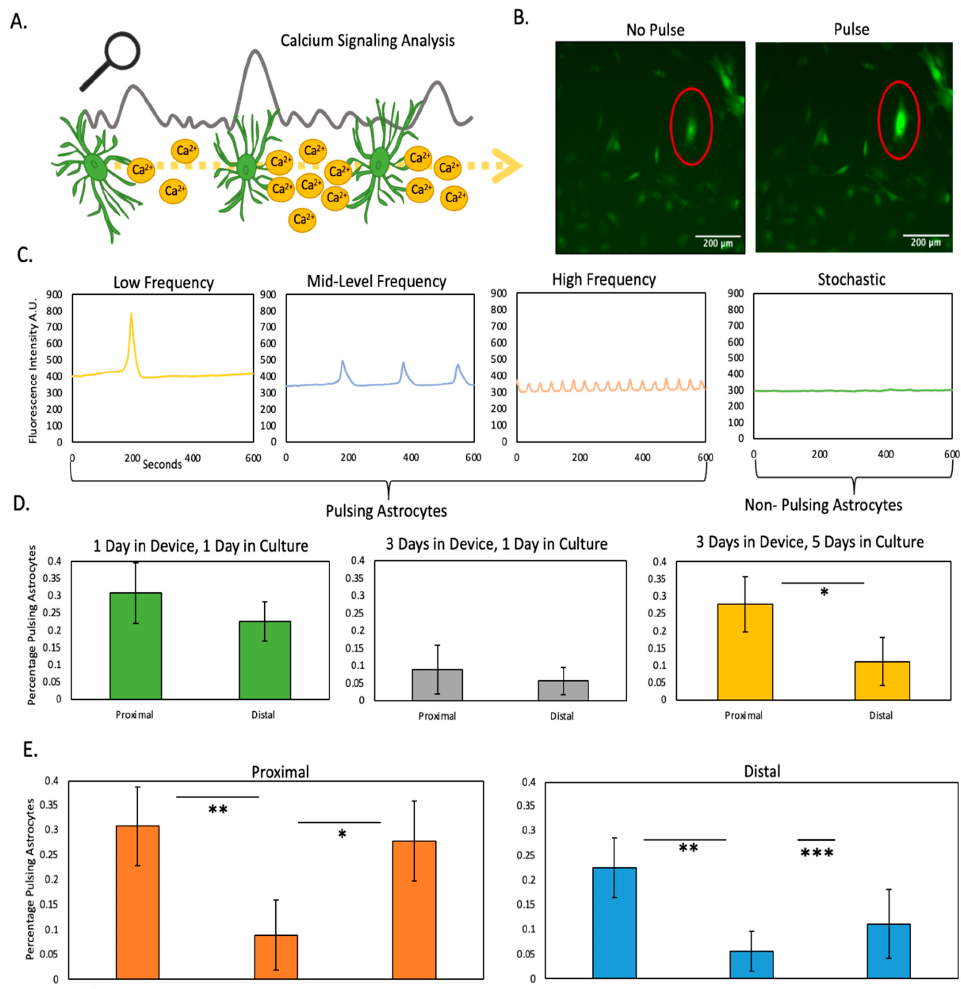
Figure 4. Calcium signaling analysis. ( A ) Illustration depicting analysis of calcium waves generated by astrocyte signaling ( B ) Image depicting astrocytes stained with the calcium-sensing dye. Red outline highlights a pulsing astrocyte ( C ) Graph illustrating differing types of astrocyte calcium pulsing ( D ) Graphs analyzing percentage of pulsing astrocytes from device illustrating differences at proximal and distal locations at varying time points ( E ) Graphs analyzing percentage of pulsing astrocytes from device illustrating recovery potential of astrocytes at proximal and distal locations. *, **, *** denote p -value < 0.05, 0.01, 0.001